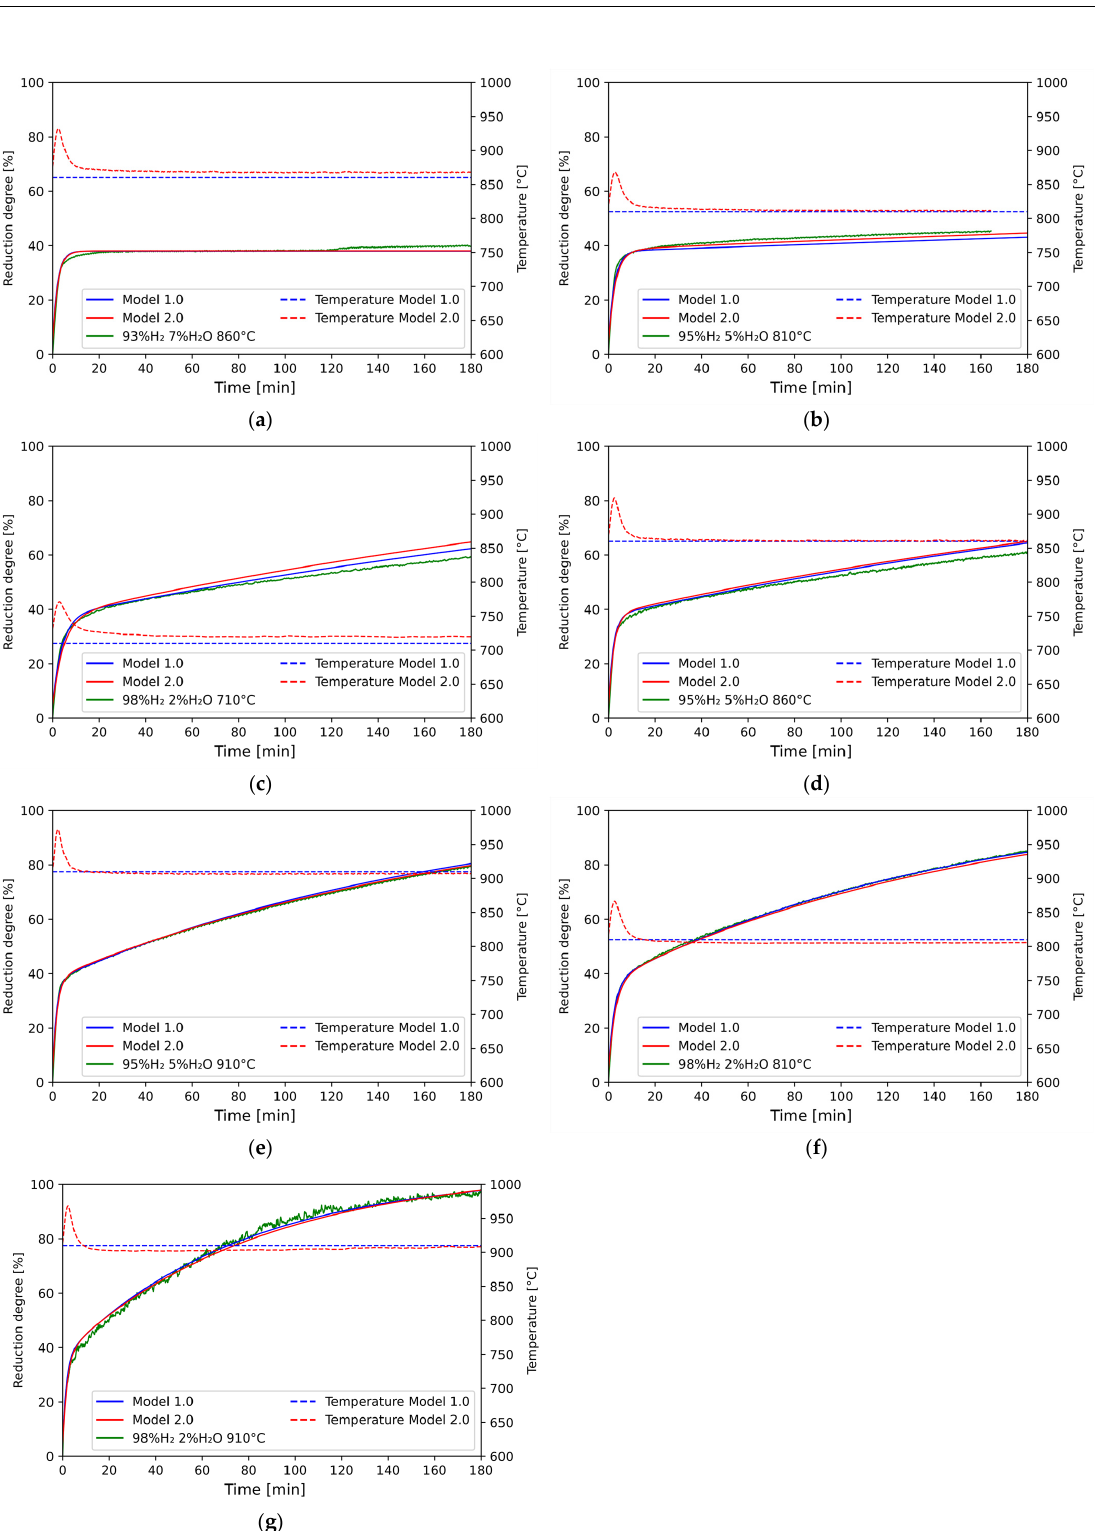
Figure 11. Reduction degree as a function of time according to (in green) the experimental measure- ment; (in blue) the isothermal model “Model 1.0”; and (in red) the non-isothermal model “Model 2.0”. Corresponding temperatures used are indicated with dashed lines of the same color. ( a ) Experiment at 860 °C and 93%H 2 ; ( b ) experiment at 810 °C and 95%H 2 ; ( c ) experiment at 710 °C and 98%H 2 ; ( d ) experiment at 860 °C and 95%H 2 ; ( e ) experiment at 910 °C and 95%H 2 ; ( f ) experiment at 810 °C and 98%H 2 ; ( g ) experiment at 910 °C and 98%H 2 .